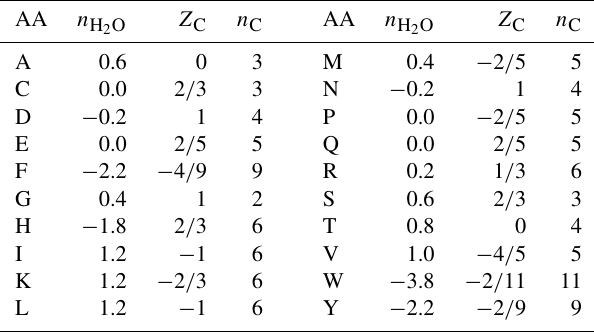
Table 1. Values of stoichiometric hydration state ( n H acids calculated with the QEC basis species (glutamine, glutamic acid, cysteine, H 2 O, O 2 ), average oxidation state of carbon ( Z C ), and number of carbon atoms ( n C ). Standard one-letter abbreviations for the amino acids (denoted AA) are